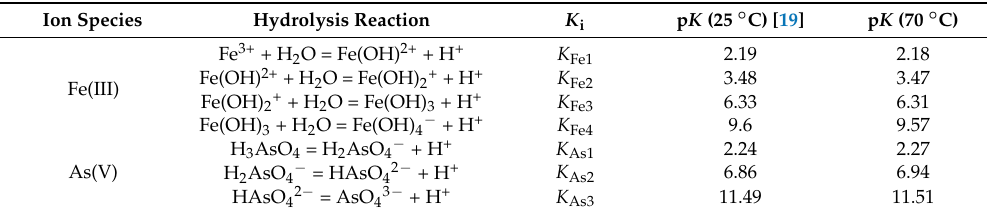
Table A1. Hydrolysis constants of Fe(III) and As(V) at 25 ◦ C [19] and 70 ◦ C calculated using the van’t Hoff